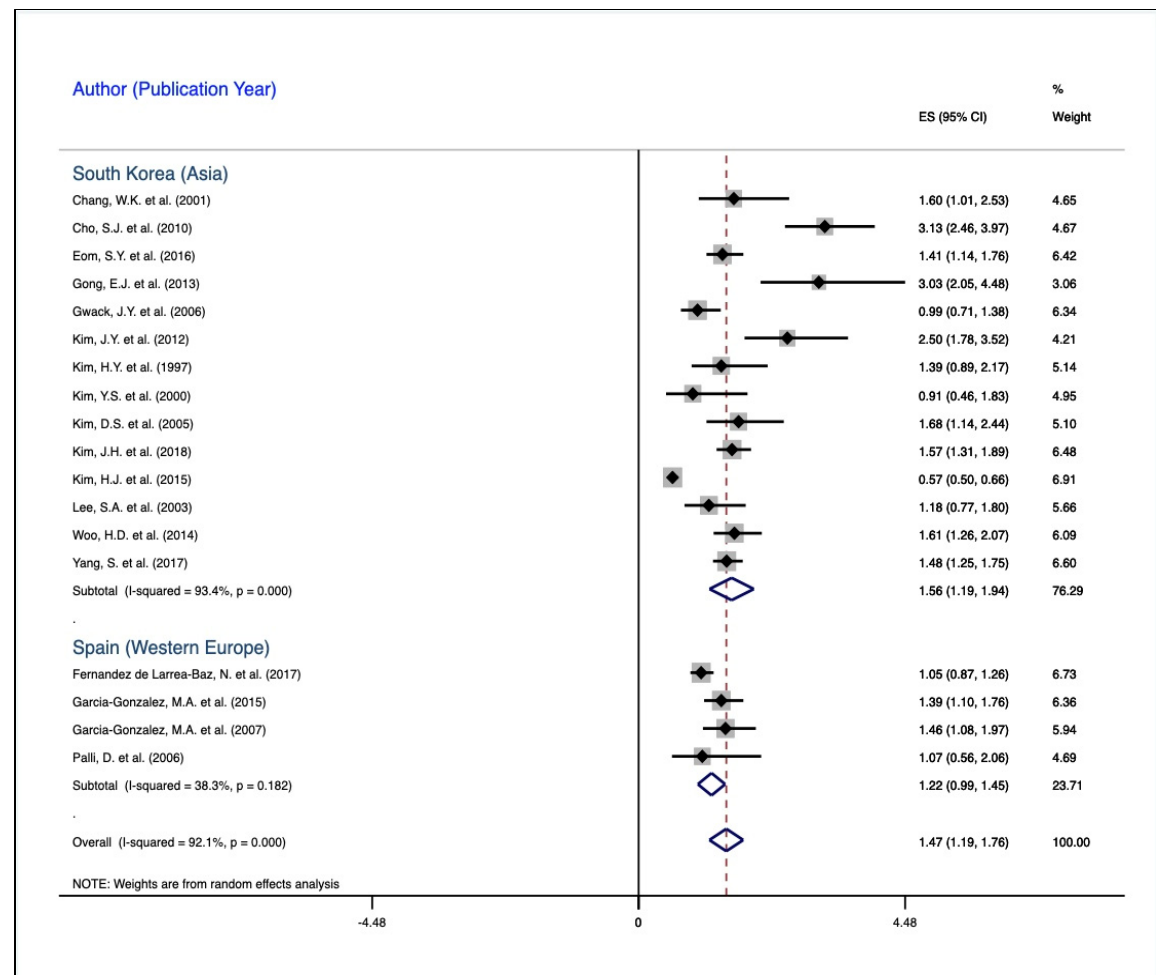
Figure 4. Meta-regression (subpopulation) correlation between H. pylori and gastric carcinoma. The subpopulations are South Korea (Eastern Asia) and Spain (Western Europe). The diamonds illustrate the common effect sizes (CES) for South Korea, Spain, and the overall population. The dots indicate the individual effect size, while the error bars represent the lower and the upper confidence limits as the measure of the precision of the individual effect sizes. Table 2. Unadjusted and pooled point-estimates from studies in South Korea and Spain with re- gards to H. pylori infection and gastric carcinoma development.